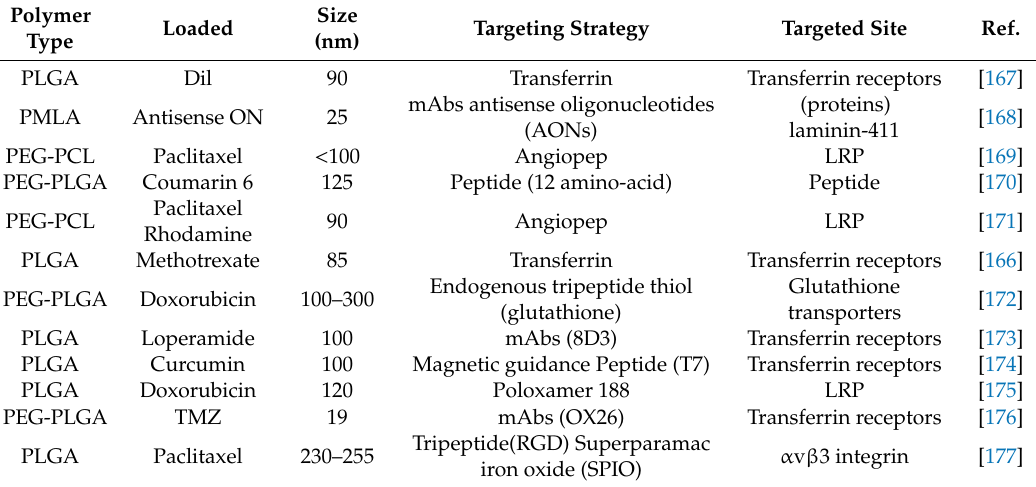
Table 1. Examples of developed targeted polymer nanoparticles as targeted drug delivery system for treatment of brain tumours malignant